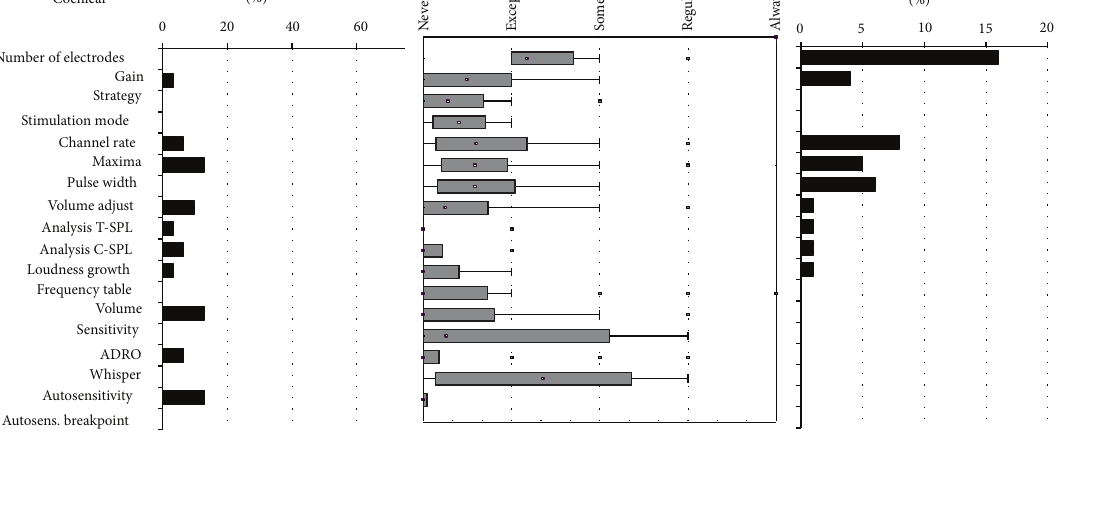
Number of electrodes Gain Strategy Stimulation mode Channel rate Maxima Pulse width Analysis T-SPL Analysis C-SPL Loudness growth Frequency table Volume Sensitivity